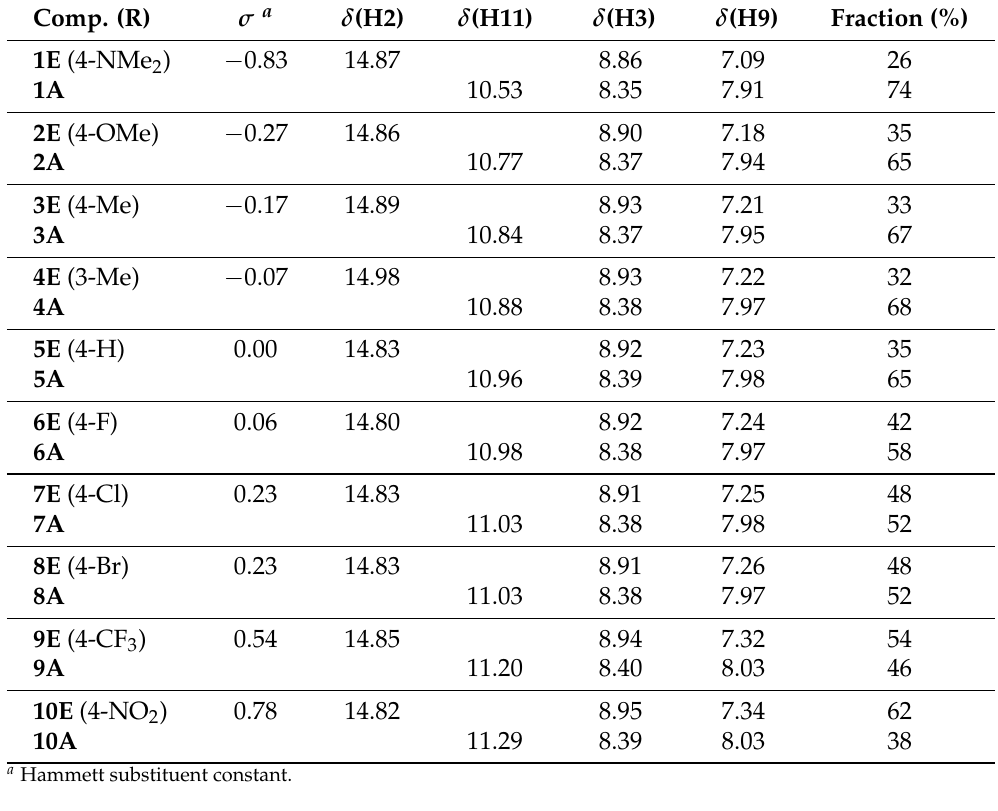
Table 1. 1 H NMR chemical shifts ( δ , ppm) for the selected protons in tautomers of compounds 1 – 10 in DMSO-D 6 and their content (last column).